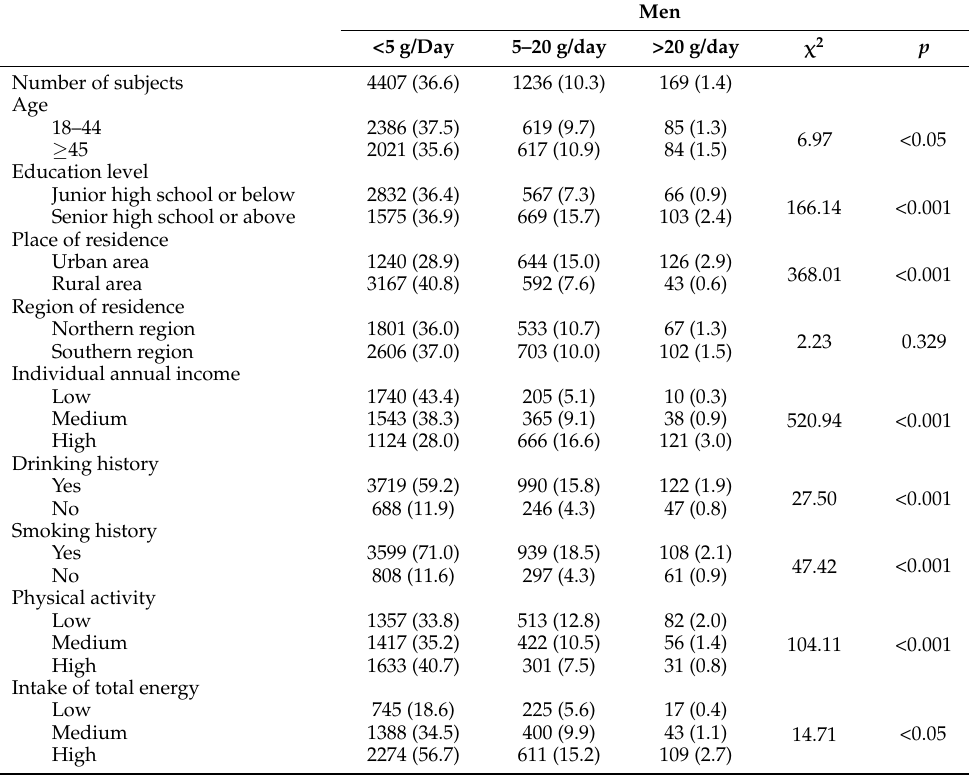
Table 2. Basic characteristics of men according to different levels of free sugars intake, CHNS.